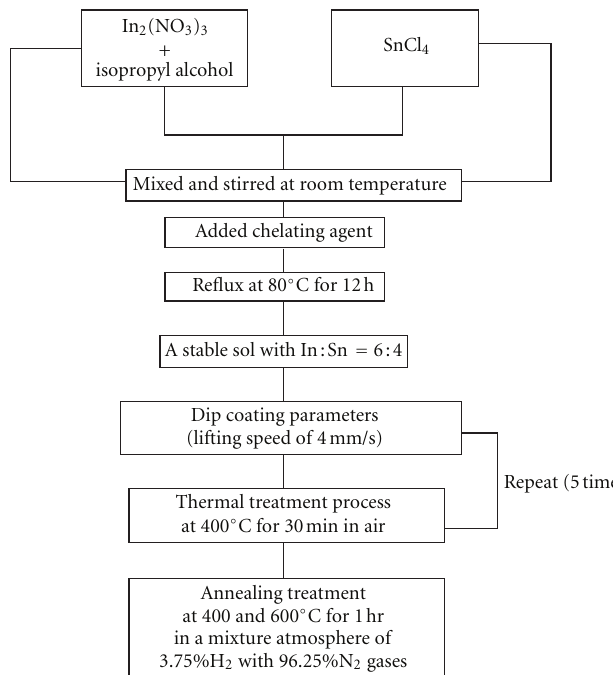
Figure 1: A diagram of the synthesis and deposition process of the prepared ITO films coating on glass